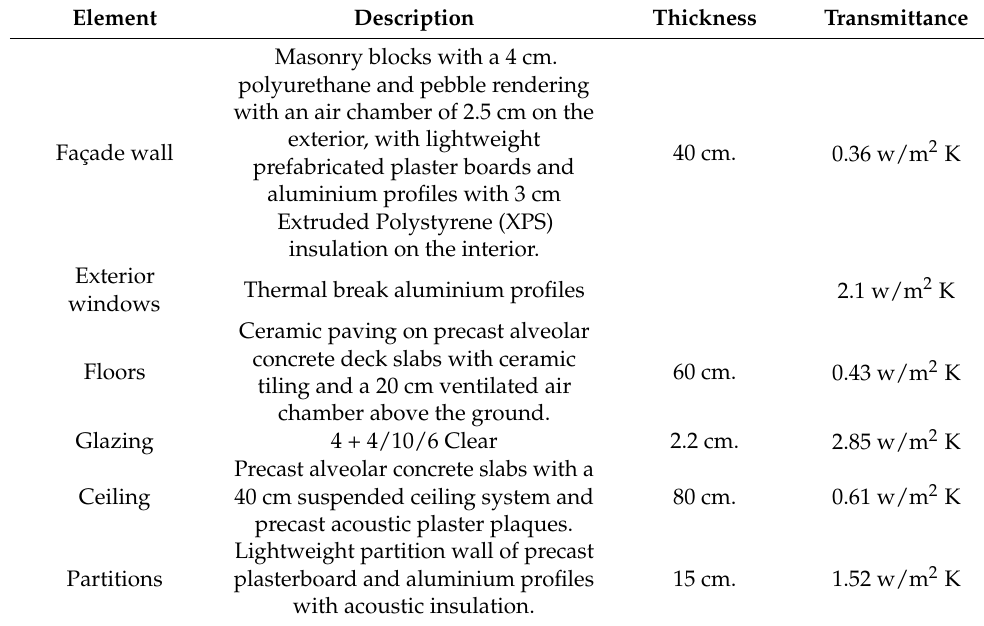
Table 2. Thermal and constructive characteristics of the envelope elements and zonal separation.